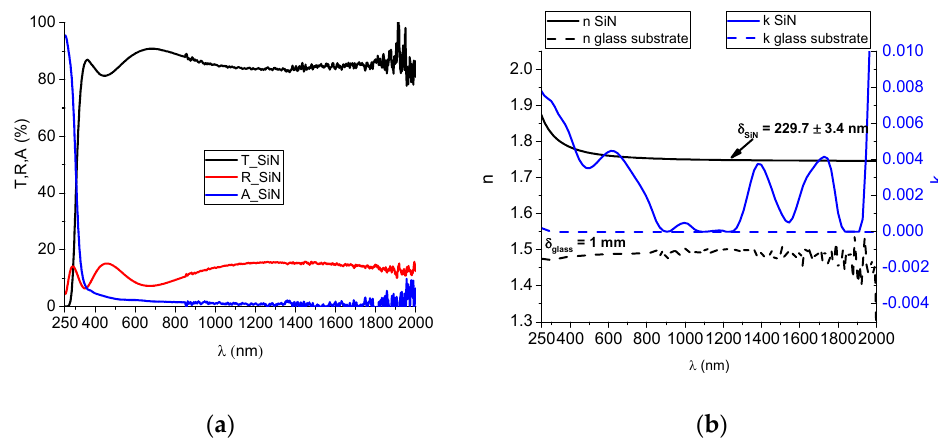
Figure 4. ( a ) Experimental spectrophotometric curves and ( b ) dispersion curves for the refractive index and extinction coefficient.